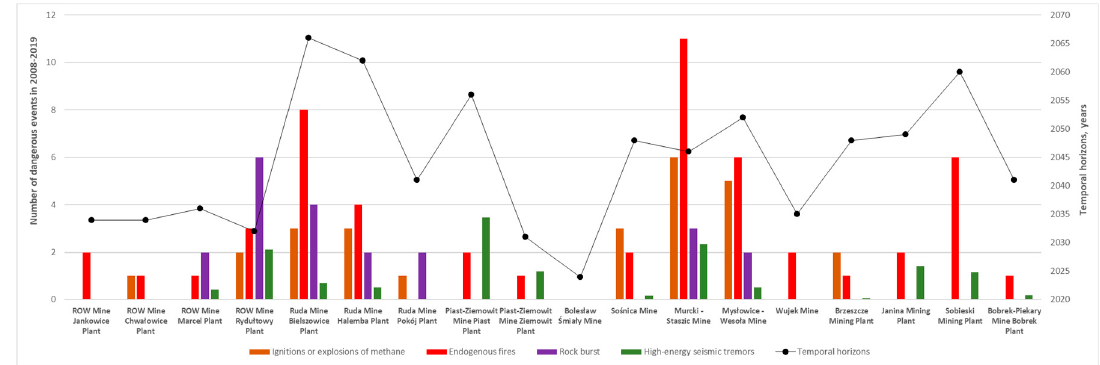
Figure 2. List of events related to the challenges that hamper the exploitation against the background of the temporal horizon of mines/mining plants, from the authors’ study.